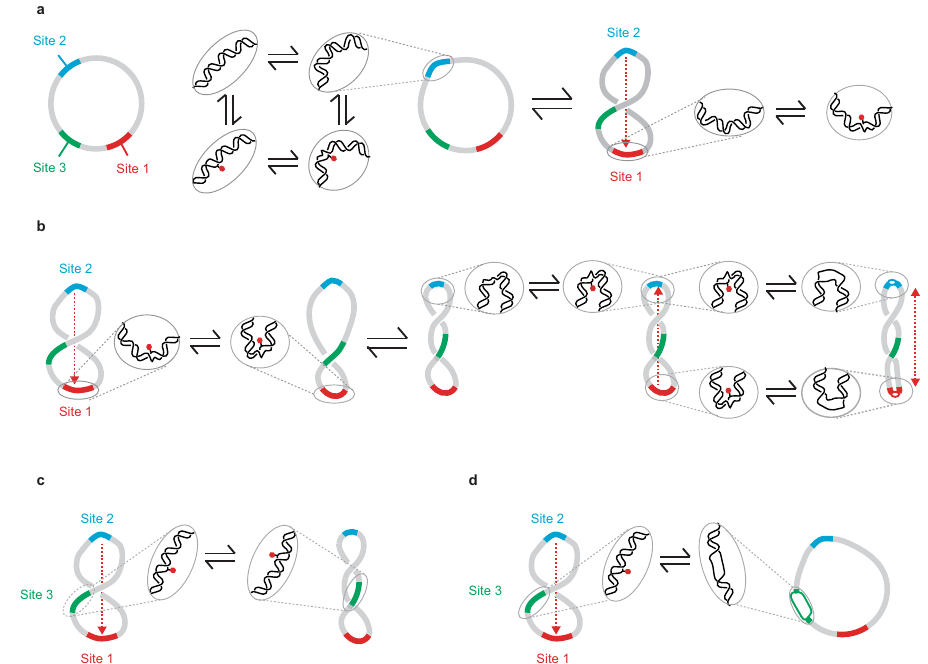
Fig. 6 Model for cooperative base exposure among distant DNA sites. a Left, location of Bal-31 and S1 nuclease cleavage sites on the minicircle sequence. Right, sequence-dependent fl exibility, intrinsic curvature, and/or base pair disruption induces a bend at site 2. The insets show the details of the local structure of the double helix with fl ipped-out bases indicated in red. The bend at site 2 is localized to a superhelical apex, placing site 1 at the opposite apex. Increased bending at site 1 leads to disruptions in base pairing. The red dashed line represents the mechanical correlation between the two sites, transferring superhelical strain from site 2 to site 1; the direction of the correlation is indicated by the arrow. b Base pair disruption at site 1 introduces a hyper fl exible site, allowing the plectoneme loop containing site 1 (red) to become smaller; therefore, facilitating writhe. Increased writhe subsequently reduces the size of the plectoneme loop containing site 2 (blue). The resultant bending strain increases the propensity for base-pair disruption at site 2. With increased negative supercoiling, denaturation sites expand, leading to single-stranded DNA bubbles at the apices. c . Site 3 does not appear to be preferentially localized to a superhelical apex. Increased writhe does not affect DNA bending at site 3; therefore, disruption at site 3 probably does not facilitate writhe. d Torsional strain relieved by extensive denaturation instead of writhe when base-pair disruption occurs at site 3 instead of sites 1 or 2. Base pair disruption at site 3 would be detrimental to DNA